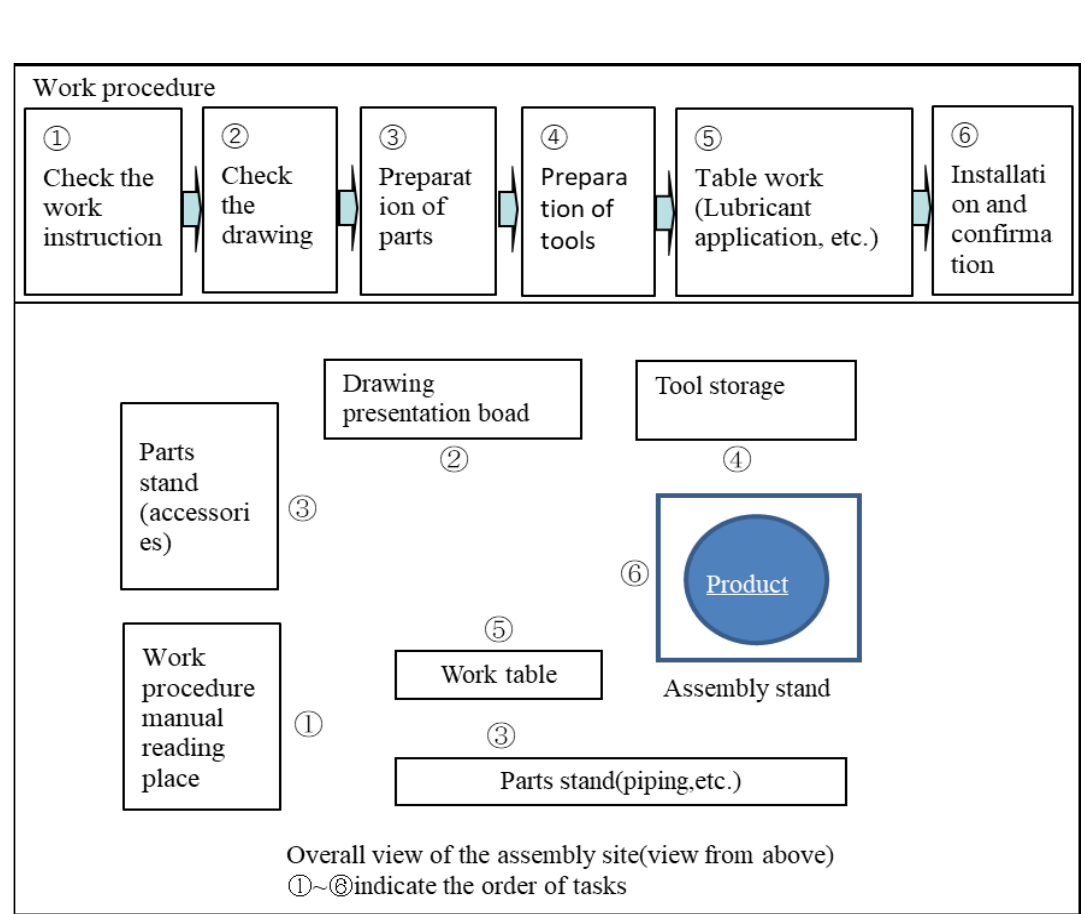
Figure 4. Gas piping system installation work